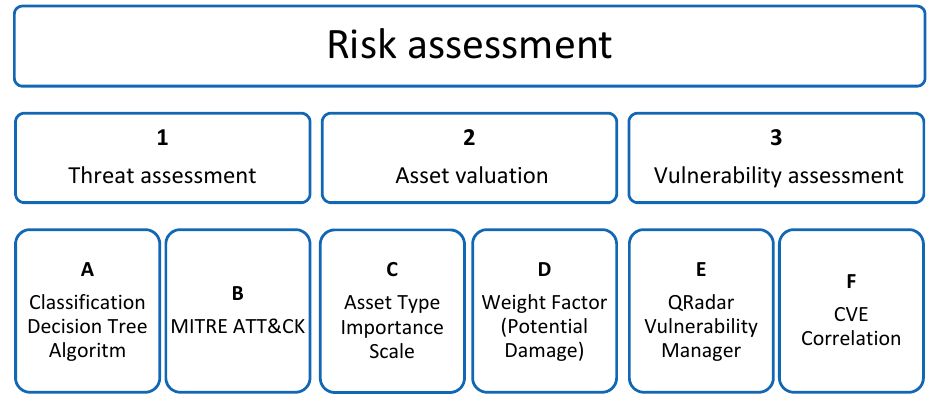
Figure 6. Risk assessment methodology.